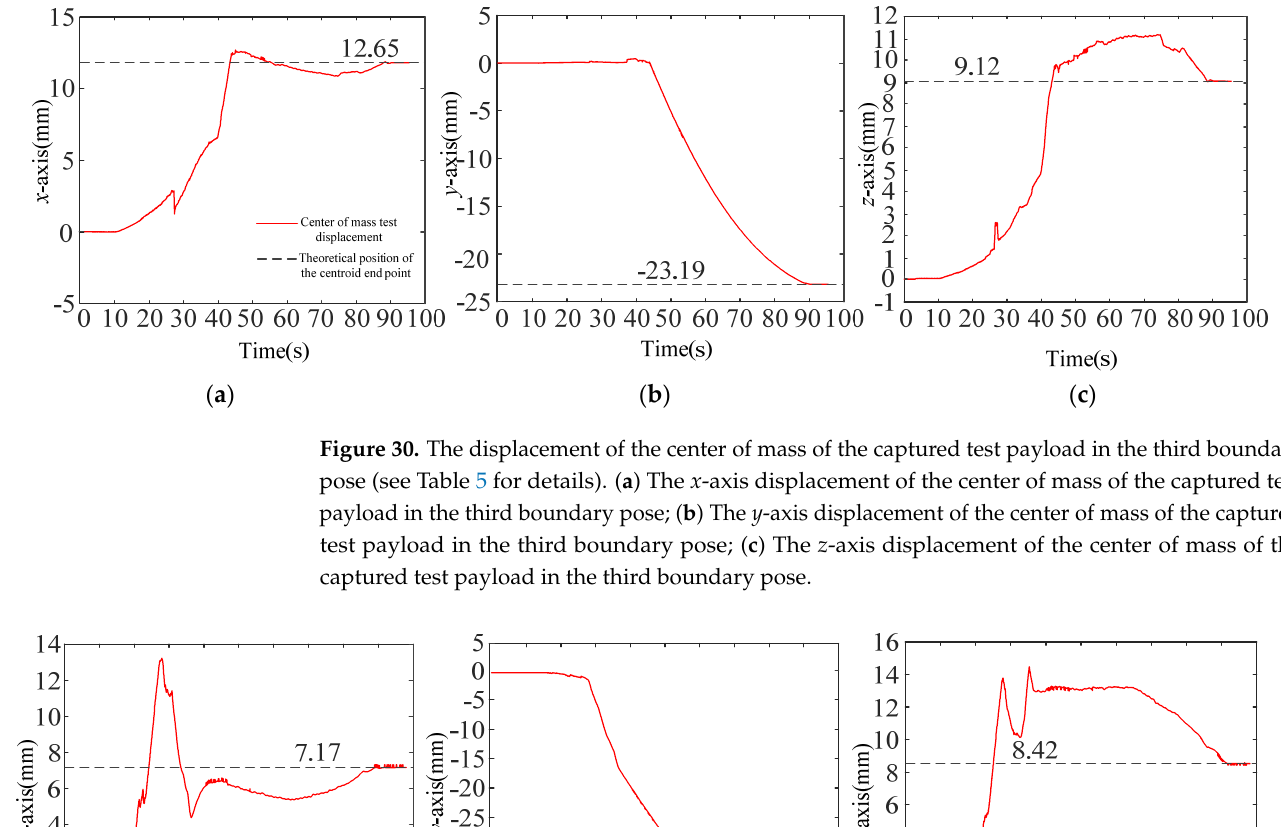
of the captured test payload in the second boundary pose.